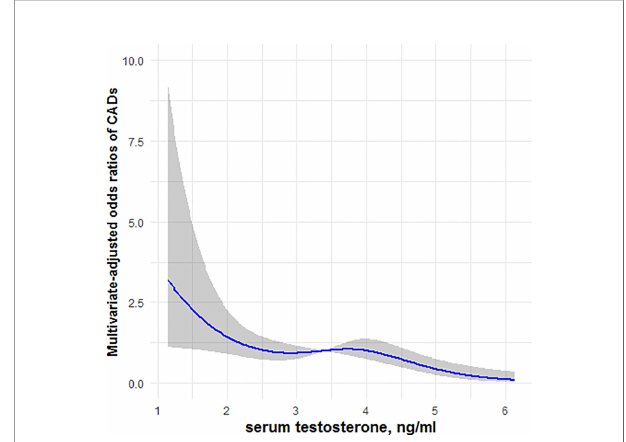
FIGURE 2 | Restricted cubic spline model of the odds ratios of CAD with serum testosterone. The gray areas represent the 95% con fi dence